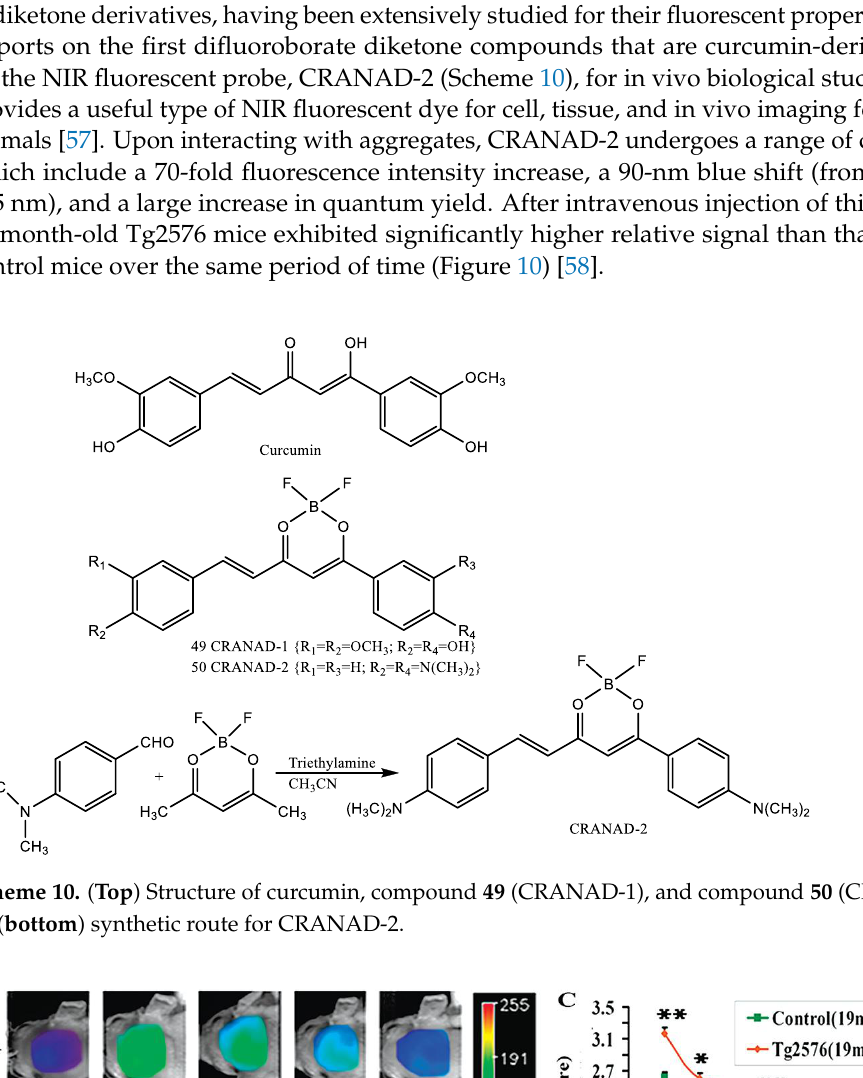
12). Fluorescence spectra and lifetimes were found to be nearly identical for dyes in CH 2 Cl 2 solution; whereas, emission maxima and lifetimes were different among the samples in the solid state as powders, thin films, or spin cast films, The recovery time generally increased with alkyl chain length, ranging from minutes ( n = 3) to days ( n = 18). Longer chain analogues ( n ¼ 6, 12, 14, 16, 18) did not fully return to the original annealed emissive state even after months on quartz, though the dynamics are sub- strate-dependent.